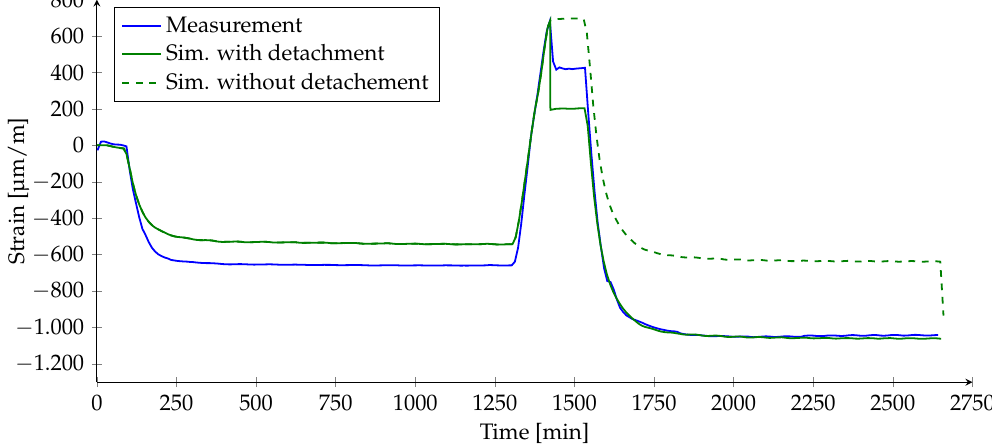
Figure 12. Comparison of the simulated strains and measured strain of panel